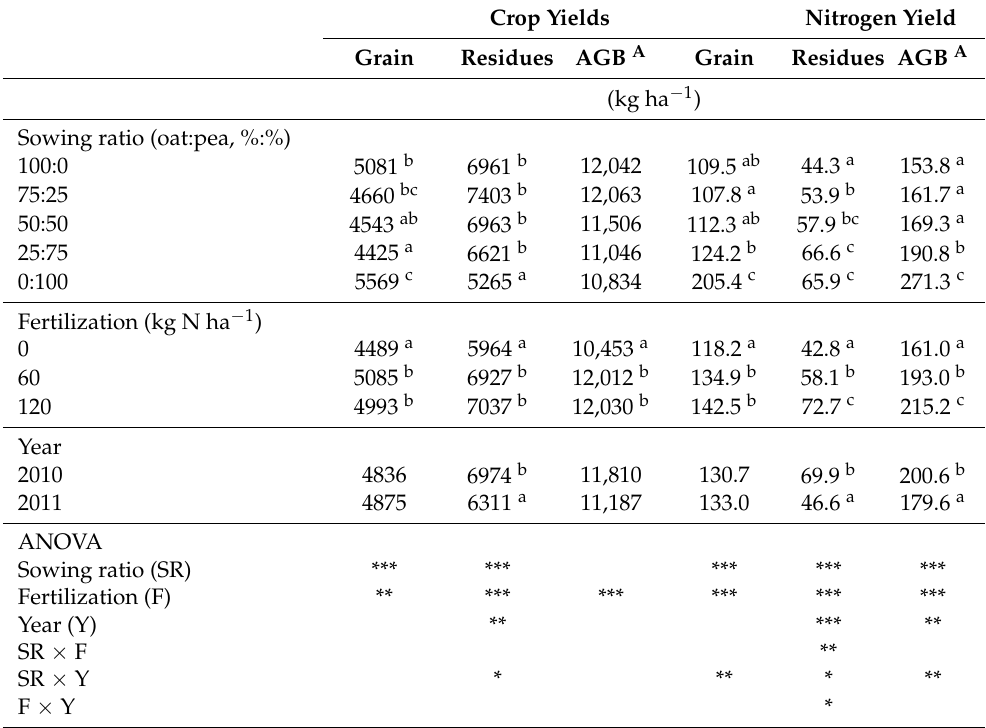
Table 5. Crop yields and N yields of oat:pea intercrops as affected by sowing ratio, N fertilizer level and year. Crop Yields Nitrogen Yield Grain Residues AGB A Grain Residues AGB A (kg ha − 1 ) Sowing ratio (oat:pea, %:%)